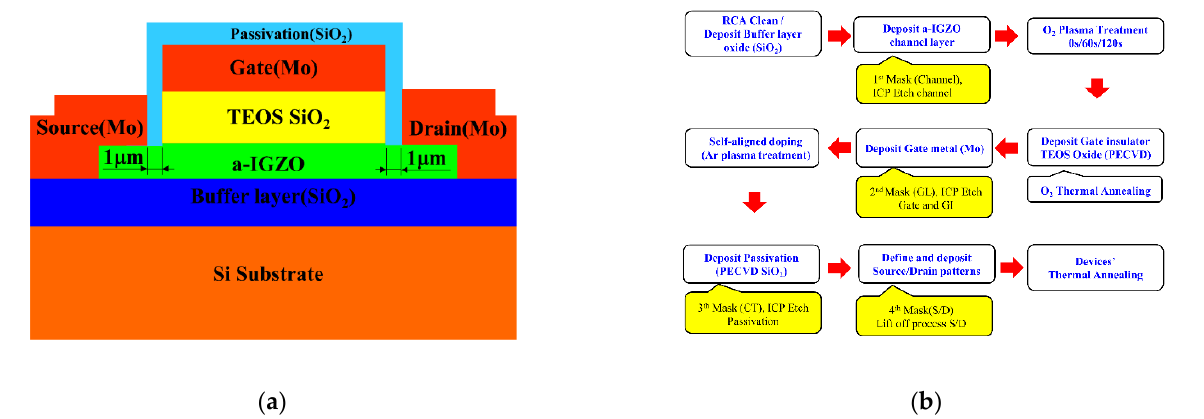
Figure 1. ( a ) Cross-sectional diagram of a top-gate IGZO thin-film transistor (TFT) structure. ( b ) Process charts of the top-gate IGZO TFTs used in this study. In this experiment, the channel width W = 100 µ m and the channel length L = 5 µ m were used. Figure 1a shows the source and drain offsets, which were designed at 1 µ